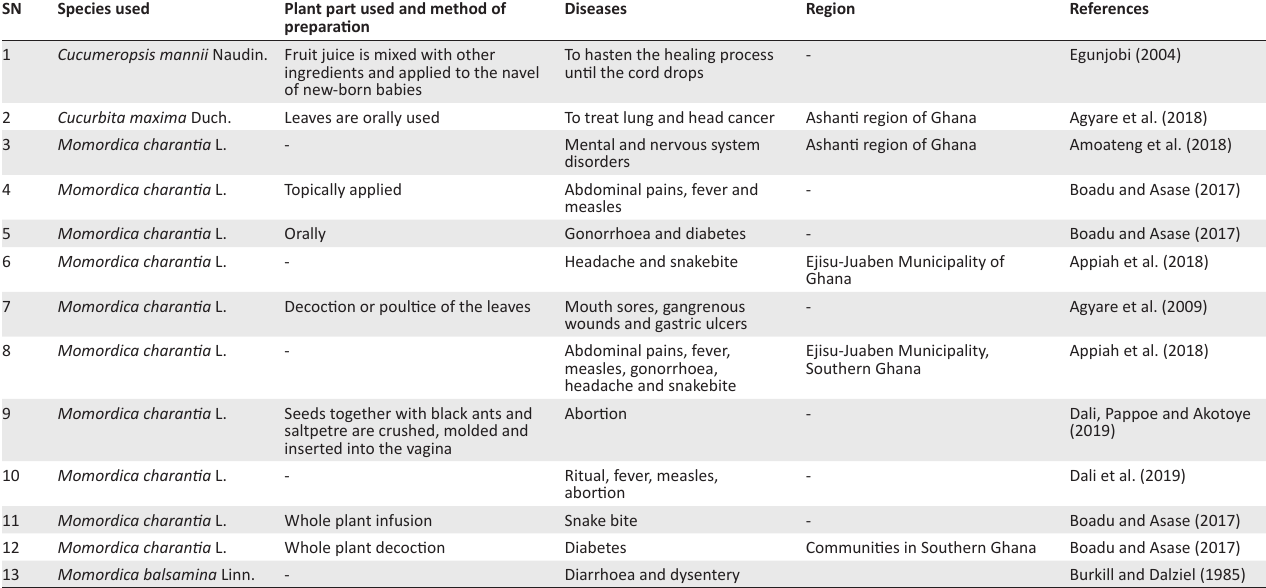
TABLE 3: Cucurbitaceae species used as traditional medicine in Ghana. SN Species used